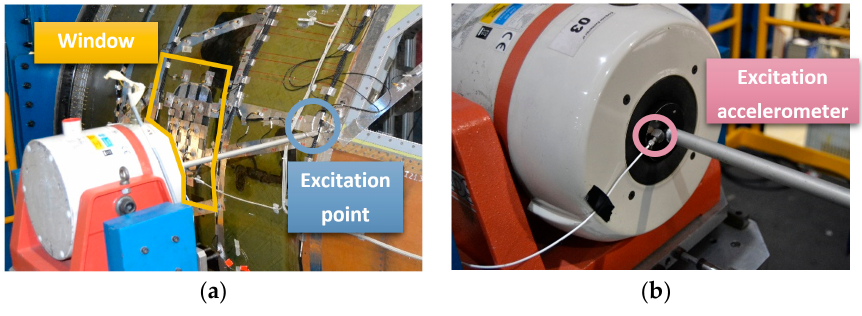
Figure 8. Lateral shaker excitation.